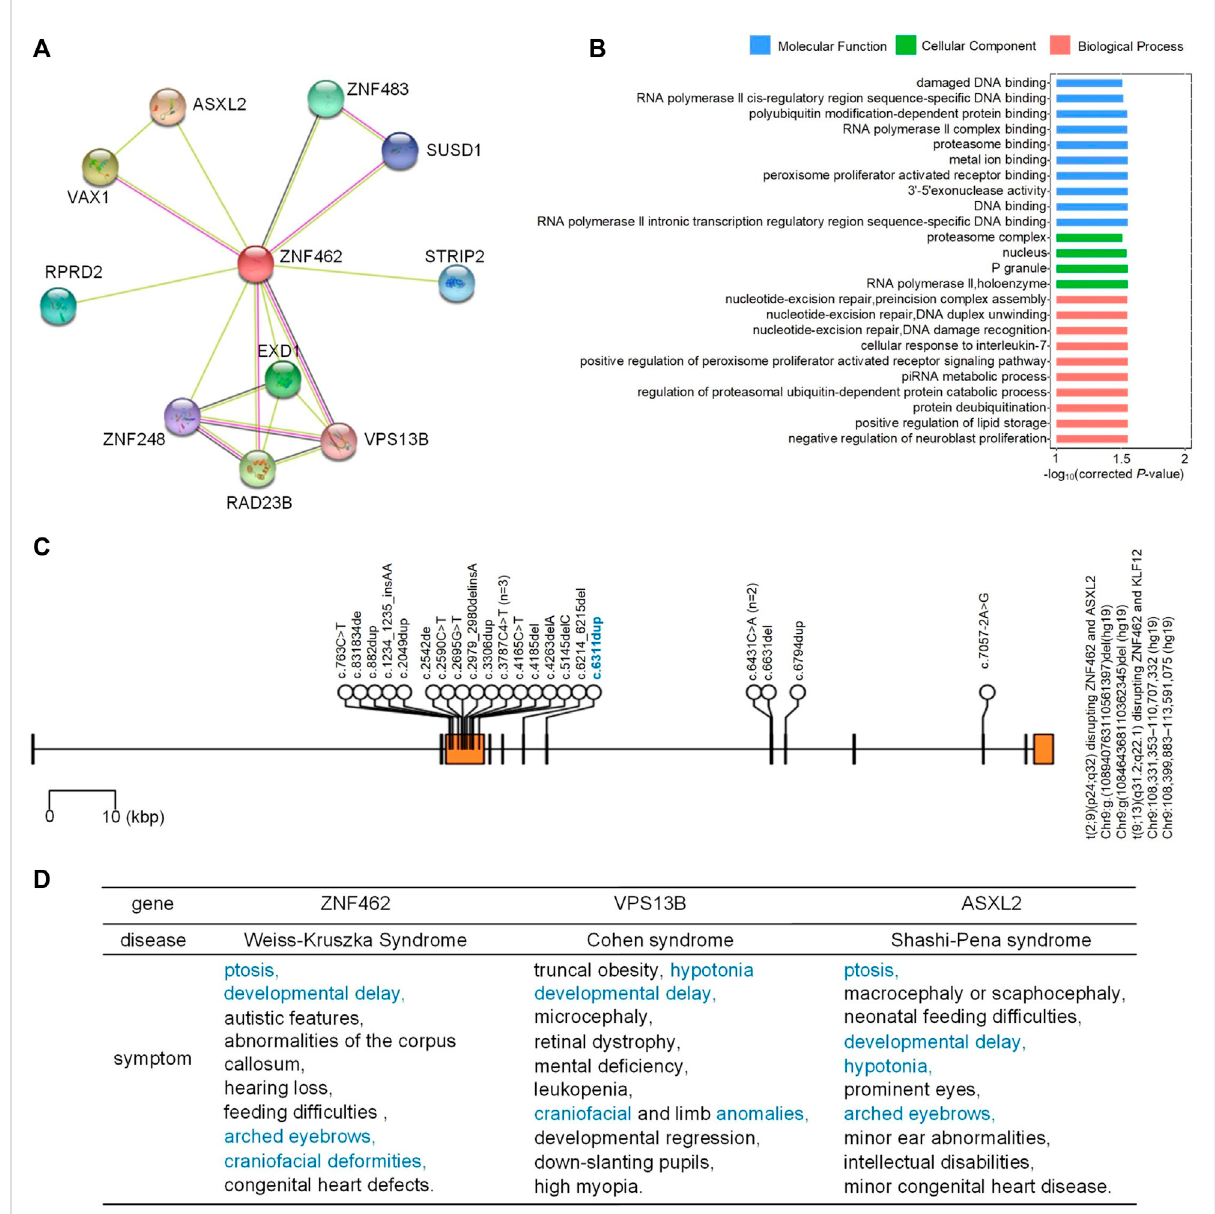
FIGURE 2 ProteinsinteractingwithZNF462andmutationsinZNF462. (A) ProteinsinteractingwithZNF462.STRING(v11.5)wasusedtopreparethe fi gure. (B) EnrichedGOtermsforgenesin (A) .OnlytopGOtermswereshown,anddetailsareprovidedinMaterialsandMethods. (C) Reportedmutationsin ZMF462 that arerelated to WSKA.The bluemutationistheone newly identi fi edinthisstudy.SeeSupplementary Table S1for details. (D) Diseasesand symptoms caused by genetic mutations in ZNF462 , VPS13B , and ASXL2 . Common symptoms of at least two diseases are shown in